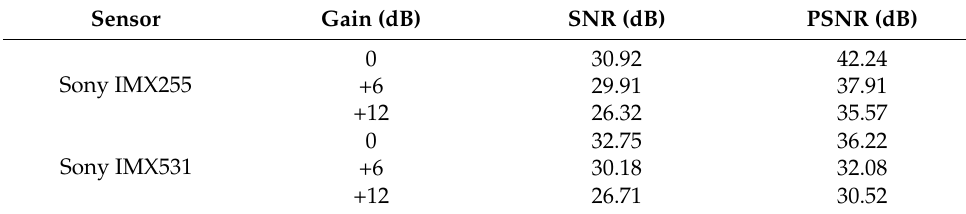
Table 3. How increasing gain affects camera